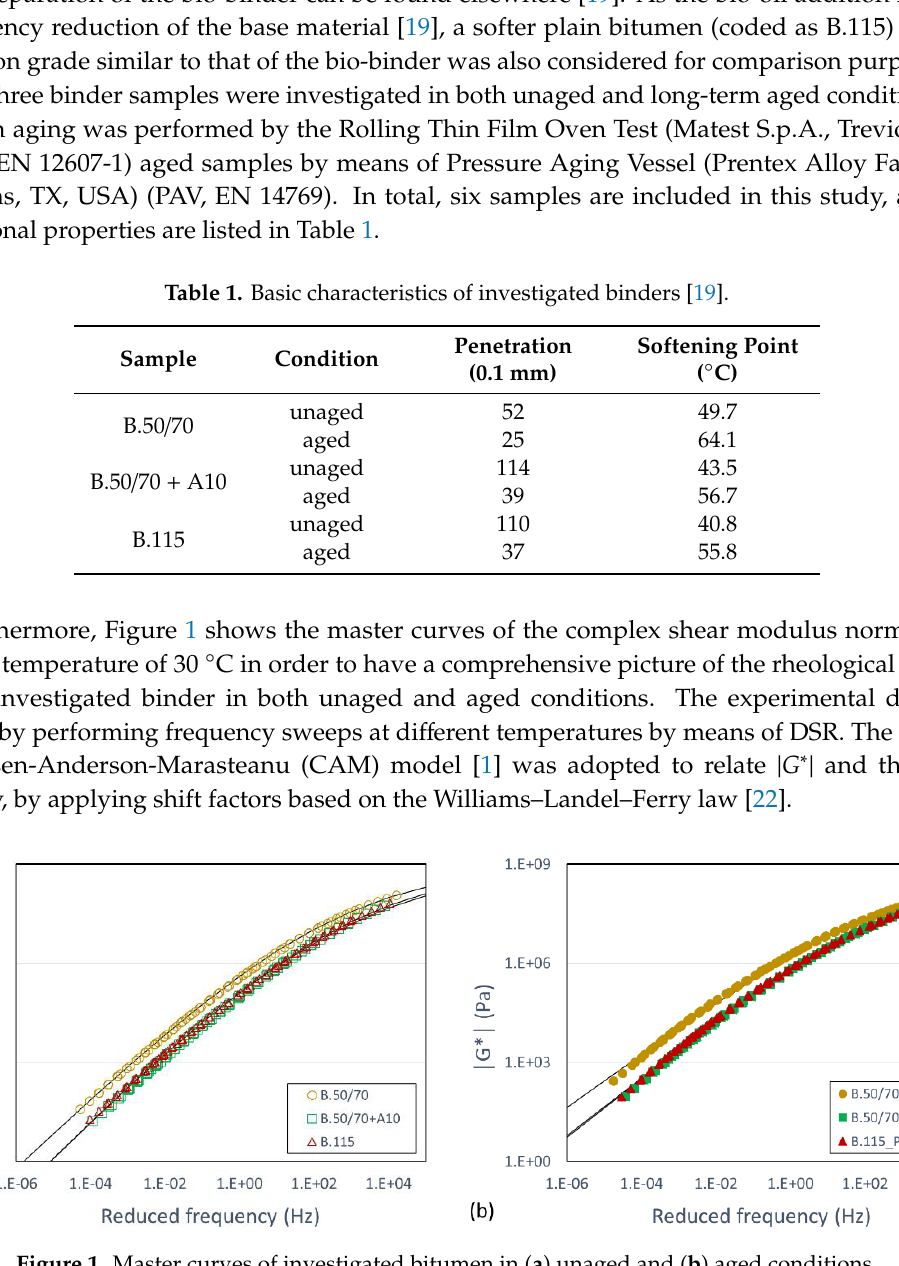
Figure 1. Master curves of investigated bitumen in ( a ) unaged and ( b ) aged conditions.